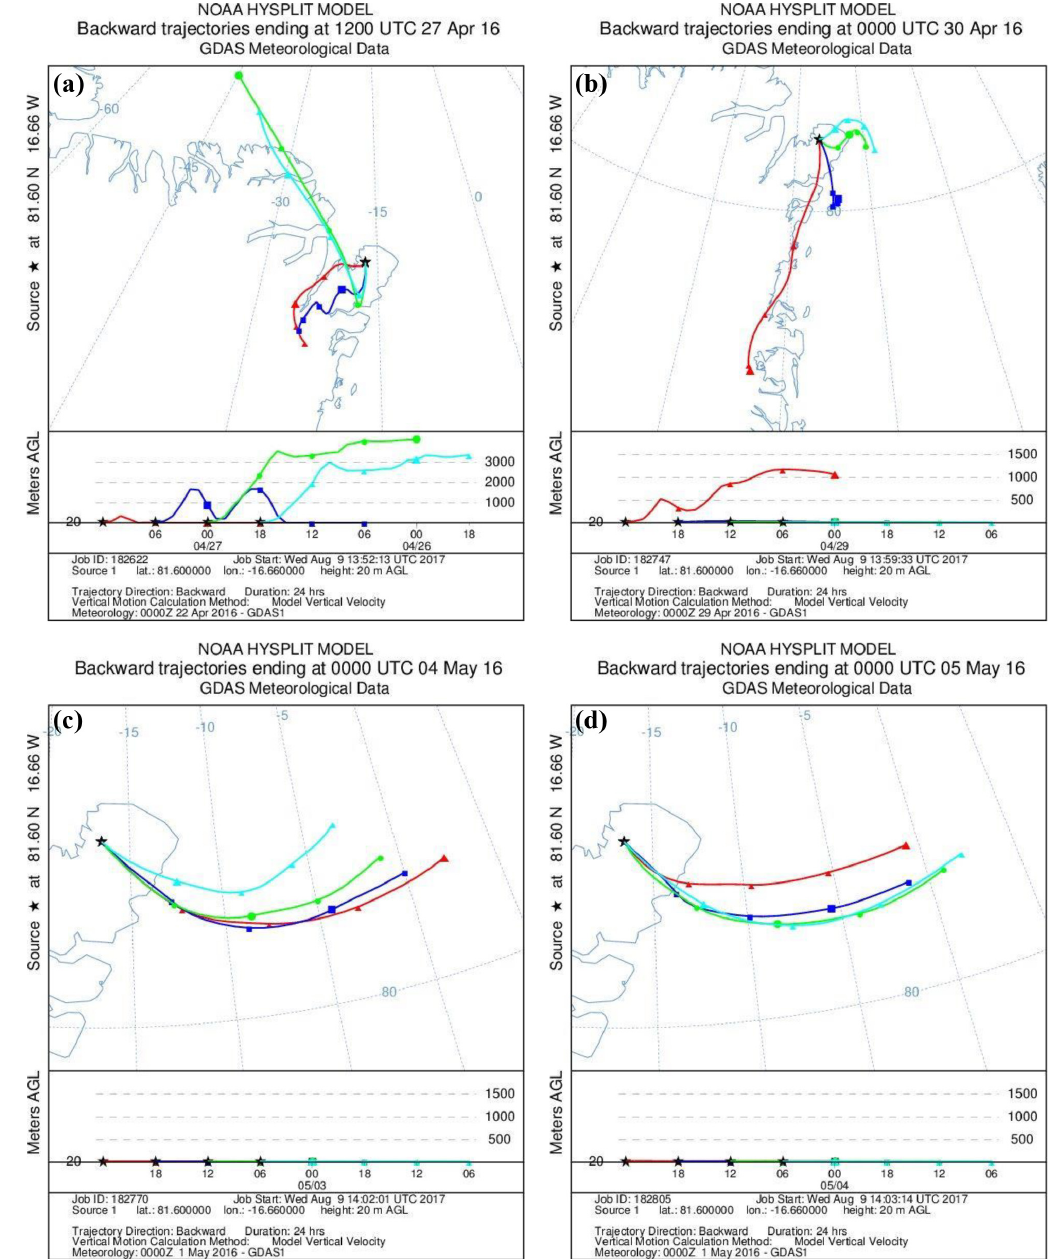
Figure 3. Backward trajectories for four different days showing the origin of the air masses. All trajectories are 24h calculations and each figure shows a new trajectory for every 6h backward: (a) starting 27 April, 12:00LT; (b) starting 30 April, 00:00LT; (c) starting 4 May, 00:00LT; (d) starting 5 May,